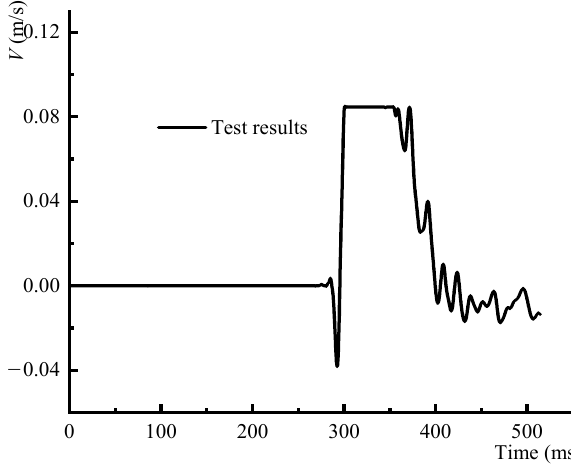
Figure 7. Velocity − time curve at the 21 m point. There are many factors that affect the parameters of explosion-induced ground shocks. The Design And Analysis Of Hardened Structures To Conventional Weapon Effects [3] used by the U.S. military provides empirical equations that relate the charge weight to the propagation of the ground shock in soil. The equations for calculating the maximum ground shock acceleration and velocity are: 𝛼 (cid:2868) 𝑊 (cid:2869)/(cid:2871) = 𝑓 × 0 × 𝑐 × ( 𝑅 𝑊 (cid:2869)/(cid:2871) ) (cid:2879)((cid:3041)(cid:2878)(cid:2869)) (1) 𝑣 (cid:2868) = 𝑓 × 160 × ( 𝑅 𝑊 (cid:2869)/(cid:2871) ) (cid:2879)(cid:3041) (2) where α 0 is the maximum acceleration (g); v 0 is the maximum velocity (ft/s); W is the C4 weight (lbs); f is the ground-shock coupling factor, which is always 0.14 for contact explo- sions or explosions in air, regardless of the type of ground [3]; c is the velocity of the seis- mic wave (ft/s); R is the distance of the measurement point from the epicenter of the ex- plosion (ft); and n is the attenuation coefficient. So, Equation (1) can be used for calculating the attenuation parameters, substituting the maximum acceleration measurements obtained from the 1 t TNT explosion at 21 and 42 m into Equation (1), the values of parameters c and n were obtained as follows: c = 457 m/s (1500 ft/s) and n = 2.55. Parameters c and n vary from one type of soil to another, as shown in Table 2. Table 2. Soil properties for calculating ground shock parameters [3]. Material Description Seismic Wave Velocity c (ft/s) Acoustic Impedance ( ρ c ) (lbs·ft/in 3 ·s) Attenuation Coefficient n Loose dry sands and gravel with a low relative density